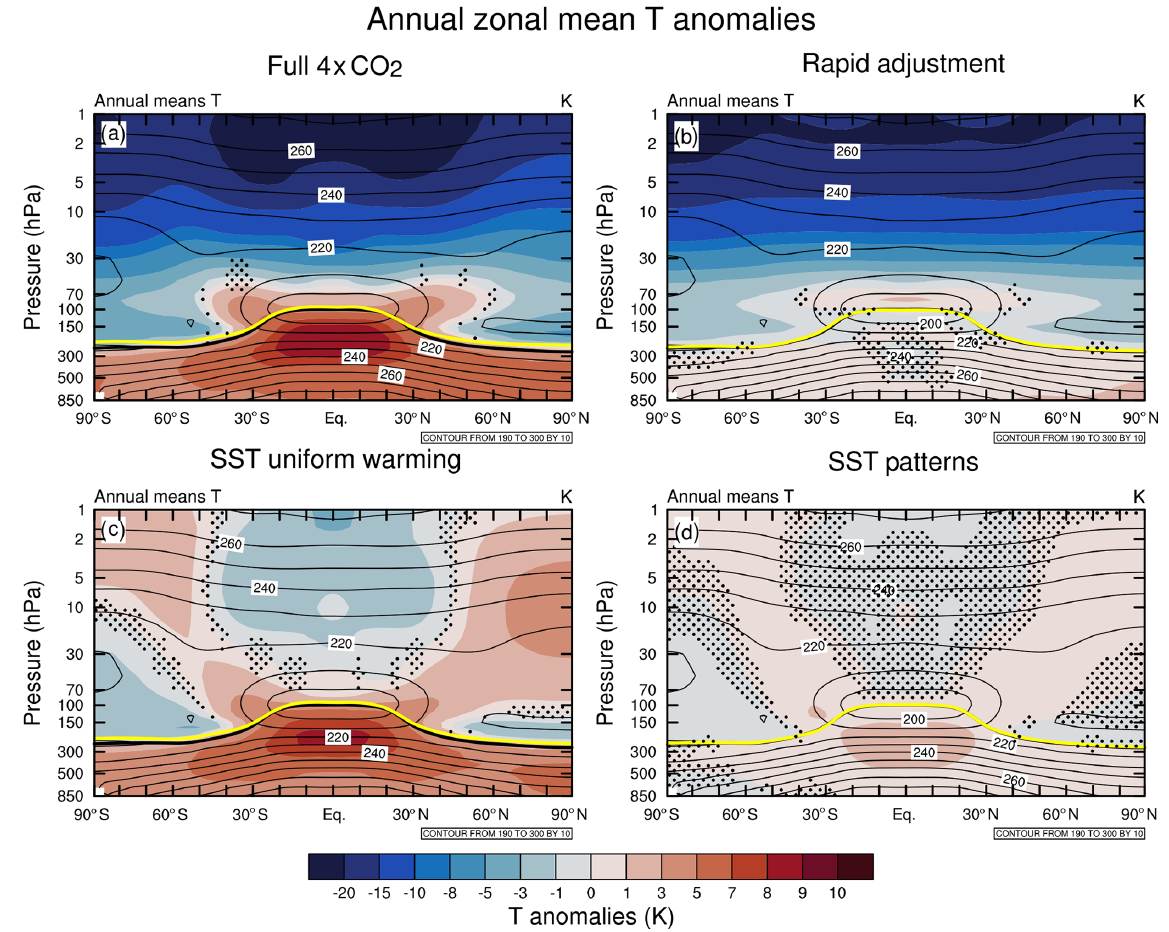
Figure 2. Latitude vs. pressure cross sections of annual-mean and zonal-mean temperature anomalies (K) between 850 and 1hPa with respect to the piControl simulation for the (a) 4 × CO 2 (run B), (b) rapid adjustment (run C), (c) uniform SST warming (run D), and (d) SST pattern (run E) experiments. Contours show the piControl climatology. Stippling denotes where the differences are not statistically significant at the 95% confidence level using a two-tailed Student’s t test. Thick yellow and black lines indicate the tropopause pressure levels in each perturbation run and in the reference simulation,